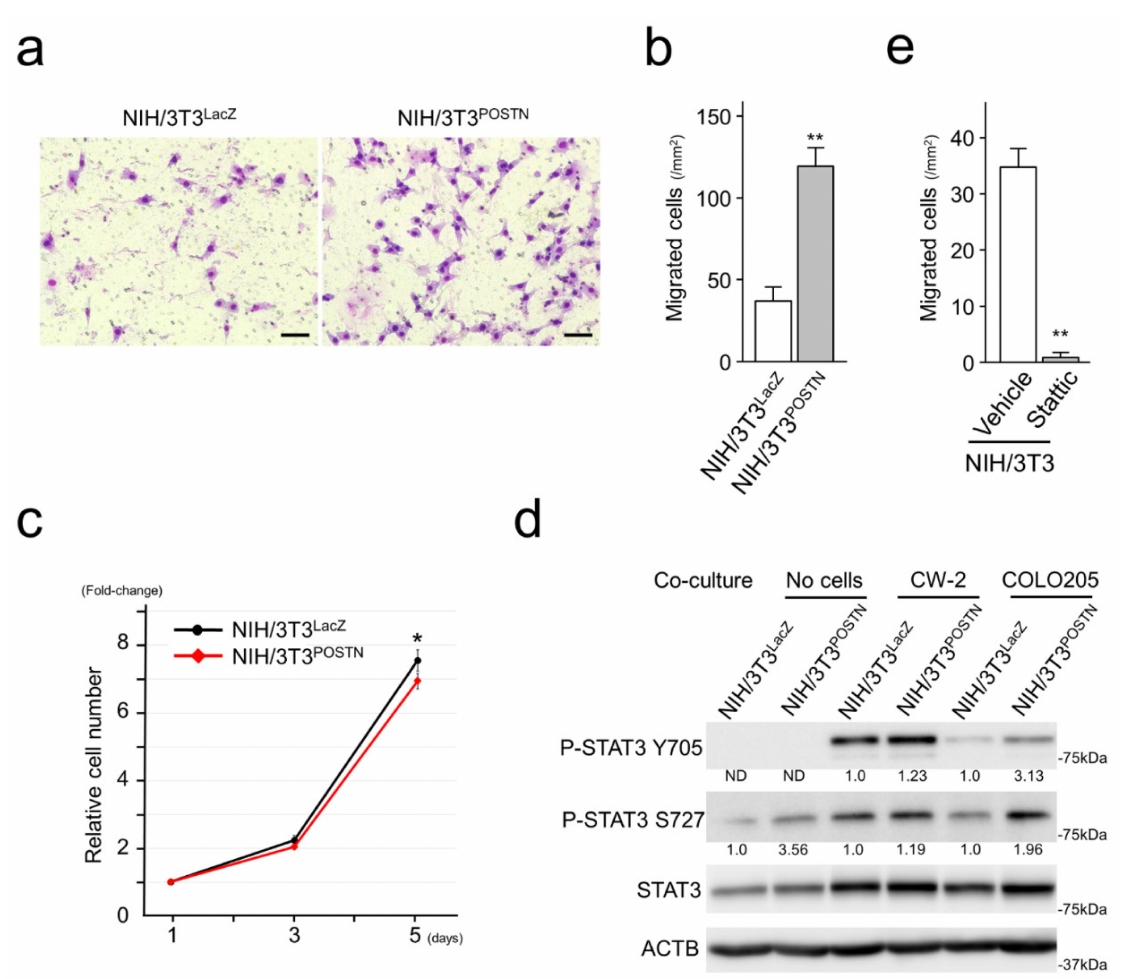
Figure 6. POSTN enhanced the motility but suppressed the proliferation of NIH/3T3 cells. ( a , b ) Exogenous POSTN enhanced the migration of NIH/3T3 cells. Bar = 100 µ m. Assays were performed in quadruplicate. Data are shown as mean ± S.D. **, p < 0.01. ( c ) POSTN suppressed the cellular proliferation of NIH/3T3 cells. Assays were performed in triplicate. Data are shown as mean ± S.D. *, p < 0.05. ( d ) Immunoblot analysis showing upregulated STAT3 and P-STAT3 in NIH/3T3 cells. Exogeneous POSTN upregulated P-STAT3 at S727. Co-culture with CRC cells up- regulated basal STAT3 and P-STAT3 at Y705 in NIH/3T3. ( e ) Stattic, a selective inhibitor for STAT3, significantly downregulated the migration of NIH/3T3 cells at 10 µ M. Assays were performed in quadruplicate. Data are shown as mean ± S.D. **, p < 0.01. The uncropped bolts are shown in Supplementary Material File